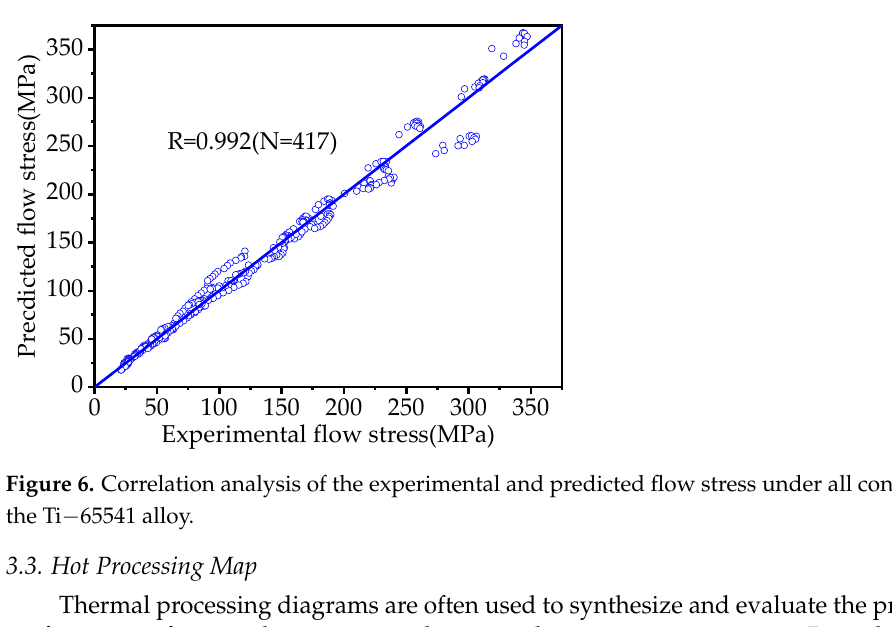
Figure 5. Comparison of the experimental and predicted stress under different strains of the